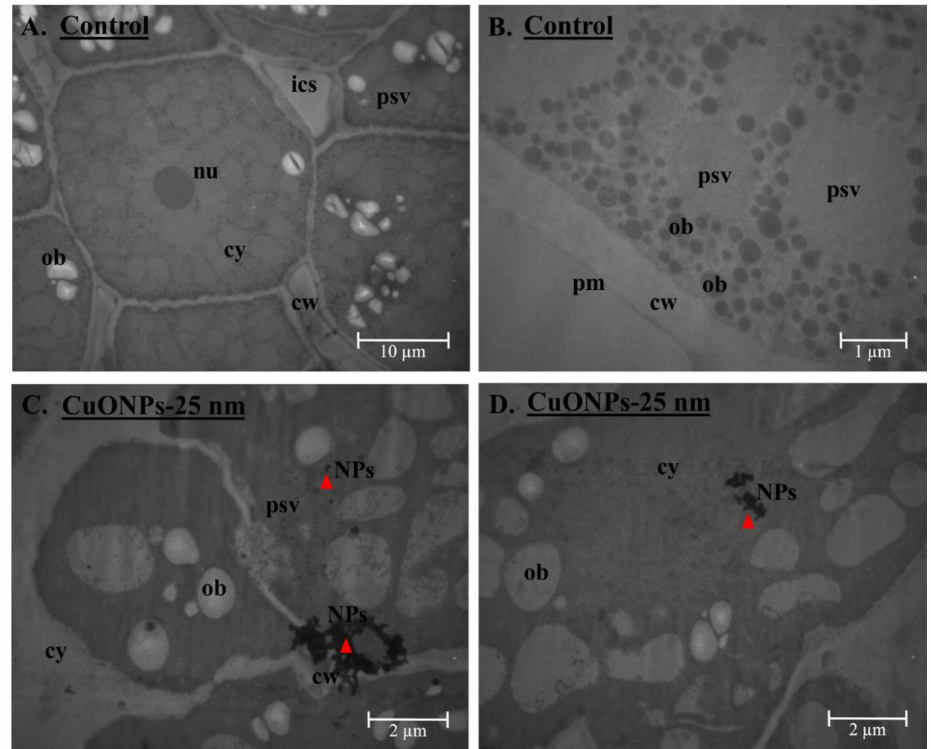
Figure 6. TEM analysis of ultrastructure of soybean seed embryo with CuONPs–25 nm treatment at 500 mg / kg soil ( C , D ) and compared with control seeds (no nanoparticles) ( A , B ). Electron-dense metal aggregates are clearly visible within the cell wall (cw) / plasma membrane (pm), including within the cytoplasm (cy) and / or protein storage vacuoles (psv) for the seeds with CuONPs–25 nm treatment at 500 mg / kg soil ( C , D ). nu = nucleus, ics = intracellular space, ob = oil bodies, NPs = nanoparticles (red